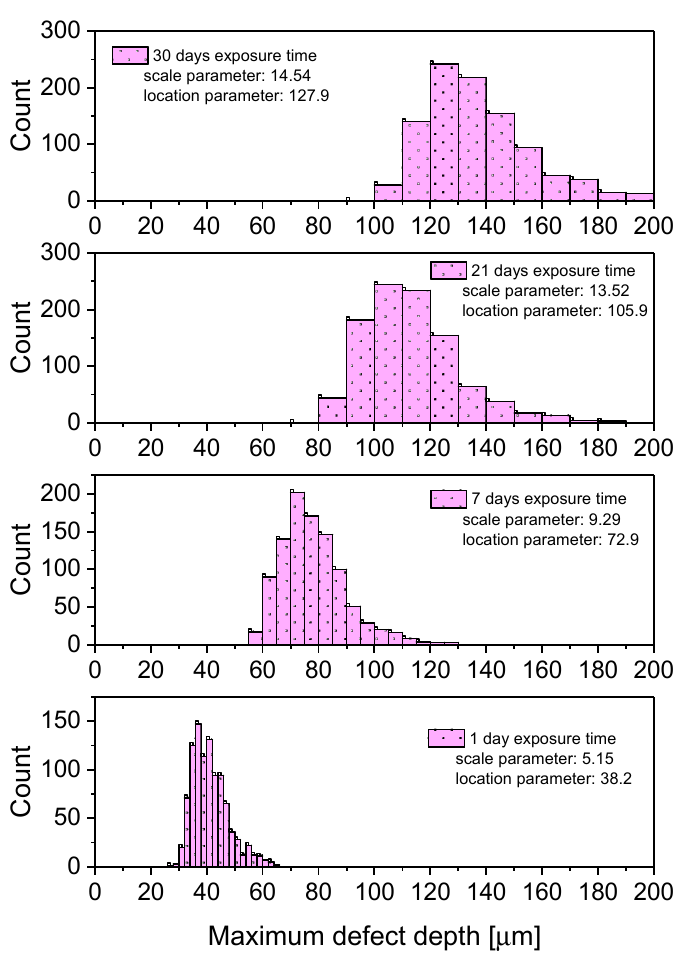
Figure 4. Histograms generated using Monte Carlo simulations for different values of location and scale parameters of Gumbel PDF. The parameters values are taken from Table 4 data from [55].